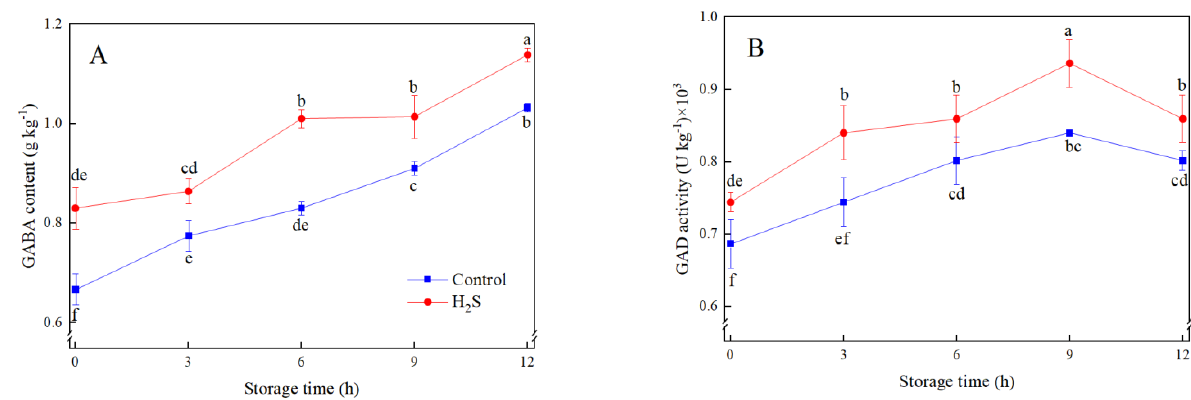
Figure 3. Effects of H 2 S treatment on GABA content ( A ) and GAD activity ( B ) of fresh-cut peaches during storage. Data are presented as mean ± standard errors of triplicate samples. Different letters indicate statistically significant ( p < 0.05) differences.